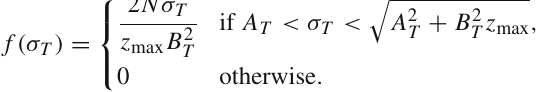
(solid orange bars) T